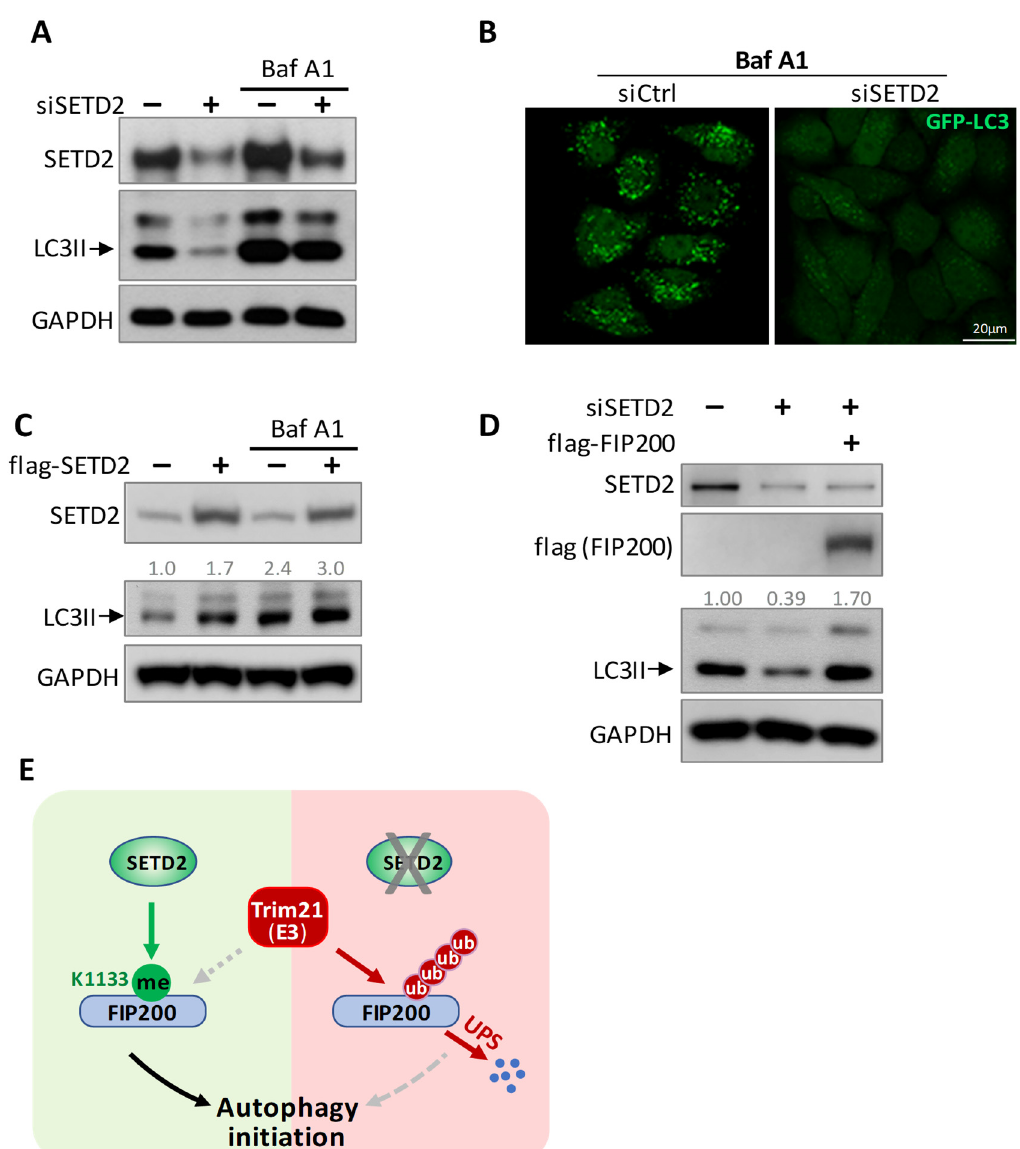
Figure 7. SETD2 promotes autophagy initiation. ( A ) Impaired autophagy initiation after SETD2 knockdown. HEK293 cells were treated with Bafilomycin A1 (Baf A1) to inhibit autophagosome-lysosome fusion. The level of autophagy marker, LC3II, was exhibited by immunoblot. ( B ) Representative images of HeLa GFP-LC3 cells showed diminished autophagosome formation upon SETD2 inactivation. Cells were transfected with indicated siRNAs, and Baf A1 was added to inhibit autophagosome-lysosome fusion. ( C ) SETD2 overexpression promoted autophagy activation. LC3II was quantified and normalized to GAPDH. ( D ) FIP200 overexpression preserved autophagy initiation after SETD2 knockdown. LC3II was quantified and normalized to GAPDH. ( E ) protein Working model. During autophagy initiation, SETD2 methylated FIP200 at K1133, stabilized FIP200, and promoted au- tophagy initiation. Without SETD2, FIP200 was ubiquitinated by Trim21 and degraded by the ubiquitin-proteasome system, leading to impaired autophagy.